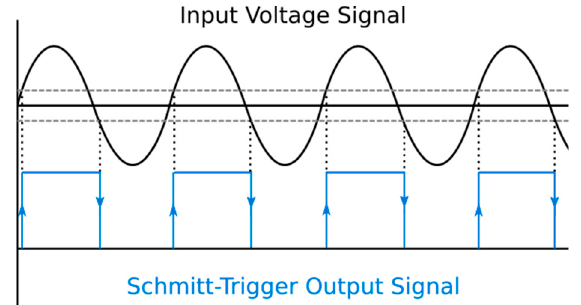
Figure 6. Schmitt -trigger effect produced with the input voltage signal. The input voltage signal is drawn as a black sinus and the output signal is the blue square signal. Scales and units are omitted for simplicity.